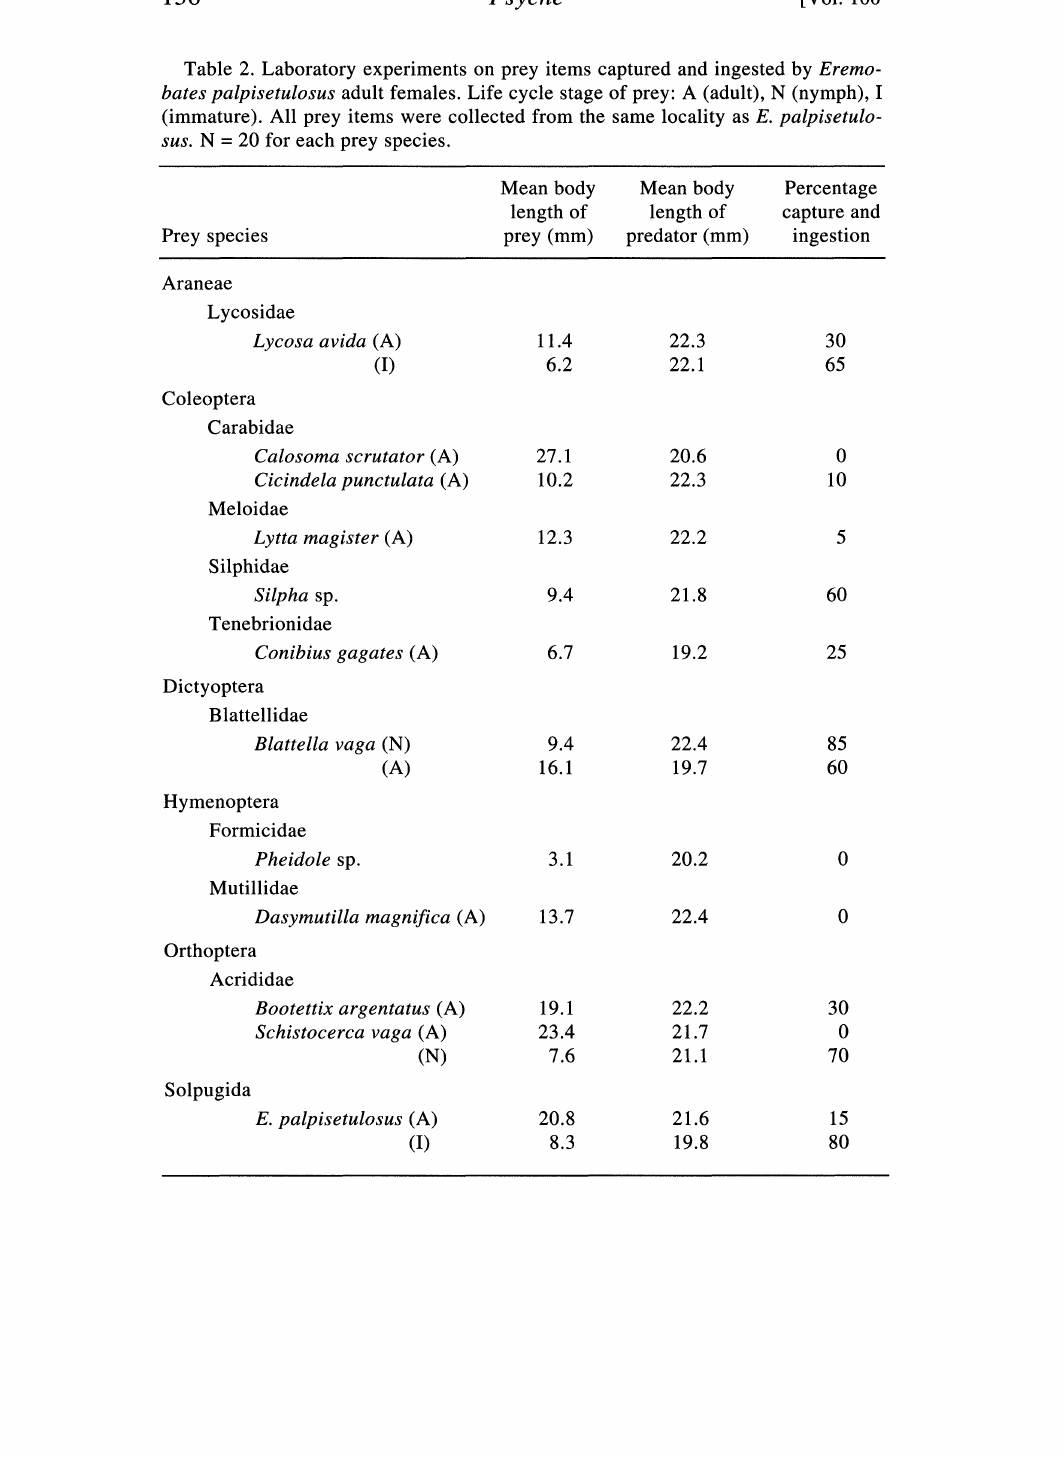
Table 2. Laboratory experiments on prey items captured and ingested by Eremo- bates palpisetulosus adult females. Life cycle stage of prey: A (adult), N (nymph), (immature). All prey items were collected from the same locality as E. palpisetulo- sus. N 20 for each prey species.